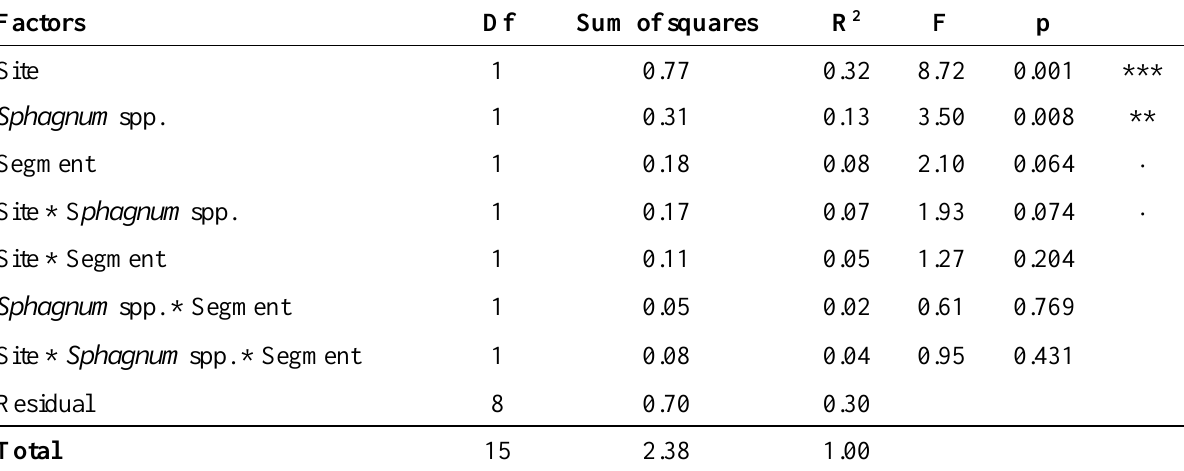
Table A6. Analysis of similarity between groups using permutations (999) on Bray-Curtis dissimilarity matrix (DM), Formula: DM by Site + Sphagnum spp. *